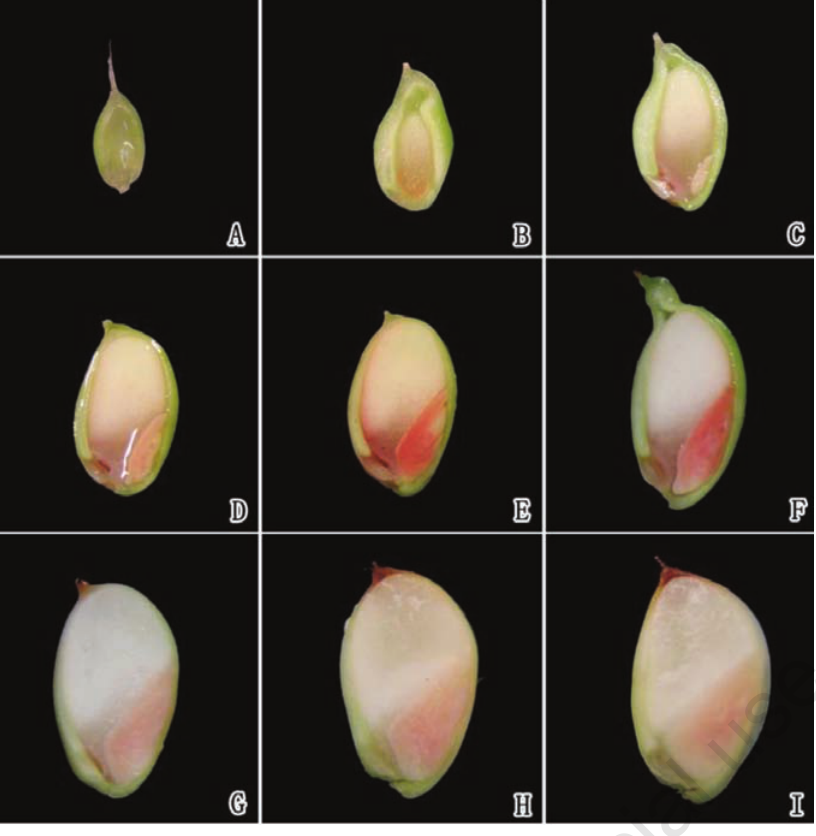
Figure 5. Sorghum embryo at different days after pollination (DAP) under the stereo - microscope. A, 3 DAP; B, 6 DAP; C, 9 DAP; D, 12 DAP; E, 15 DAP; F, 18 DAP; G, 21 DAP; H, 24 DAP; I, 27